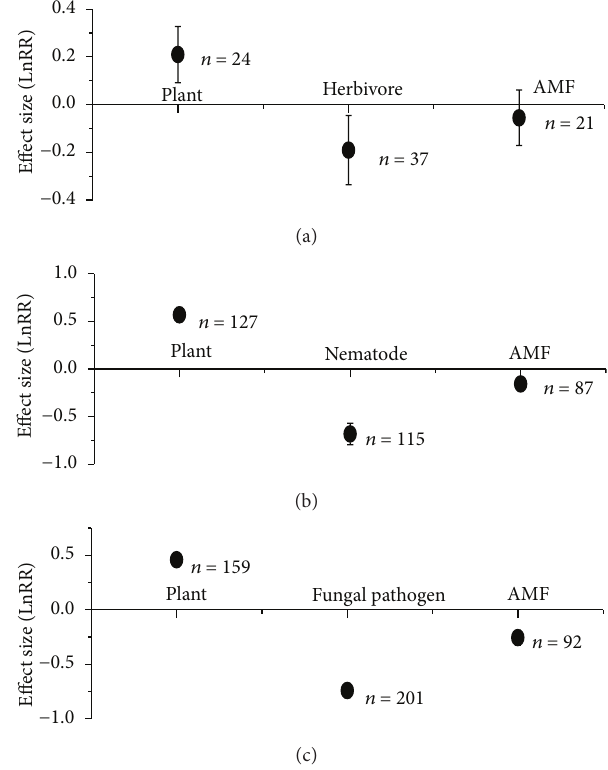
Figure 1: Effect size ( mean ± 95 % CI ) of plants, biotic stressors, and AMF. (a) Effect size of plant refers to plant growth response to AMF at herbivore attack; effect size of herbivore refers to herbivore performance response to AMF; effect size of AMF refers to AMF growthresponsetoherbivores,(b)similarto(a)butundernematode attacks, (c) similar to (a) but at pathogenic fungi stress.